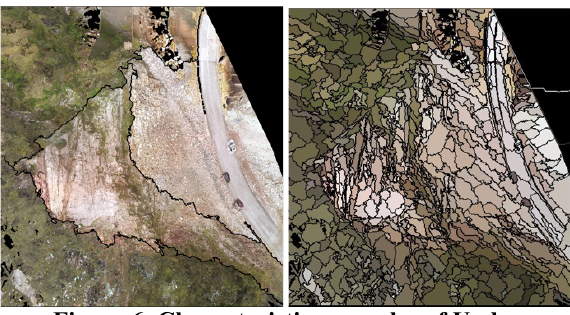
Figure 6. Characteristic examples of Under- segmentation (left) and Over-segmentation